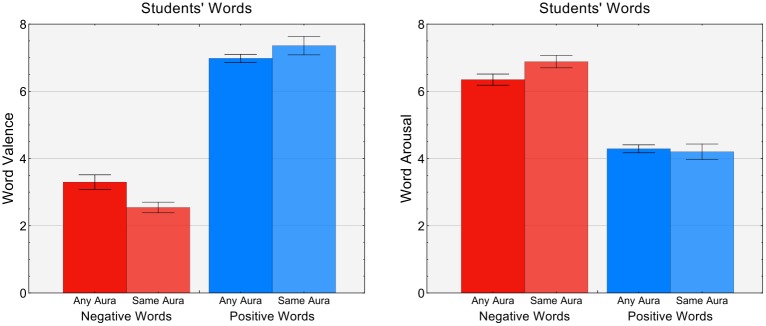
Valence auras identify more extreme negative words in the students’ population.Mean valence (left plot) from external psycholinguistic datasets of negative/positive words either surrounded by any valence auras (full colours) or by the same aura (lighter colours). In the students’ forma mentis network, negative words surrounded by negative auras are perceived as more strongly negative on average as compared to negative words surrounded by any aura. Negative words surrounded by a negative aura had higher arousal than negative words with any aura (right plot). No difference was found for positive words.